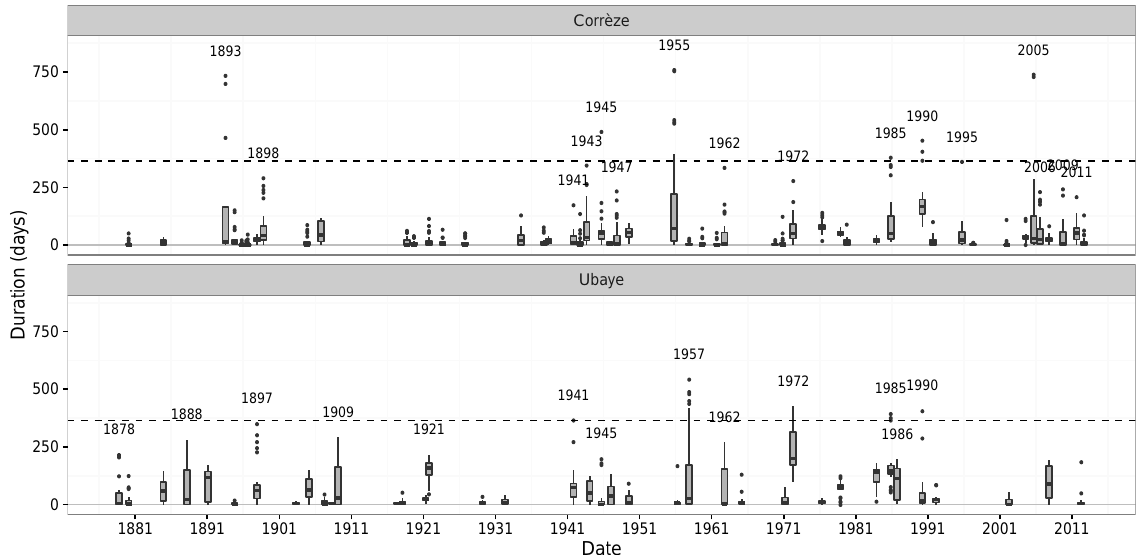
Figure 11. Extreme low-flow event duration (in days) for the Corrèze and Ubaye catchments over the 1871–2012 period. The x -axis repre- sents the spatial centre dates of the events (see Sect. 3.2.4). The 25 ensemble members are represented with a boxplot for each event. The lower and upper hinges correspond to the first and third quartiles, respectively. Whiskers extend to the smallest and largest values still within 1.5 times the interquartile range. Events with remarkable values from any given ensemble member are labelled with the year of the spatial centre date. The dashed line shows the 1-year duration for